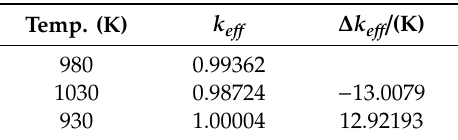
Table 4. Initial steady state calculations and determination of the feedback e ff ect for the heavy metal rich system with a radius of 160